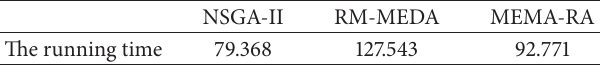
Table 2: The comparison of the running time (unit: